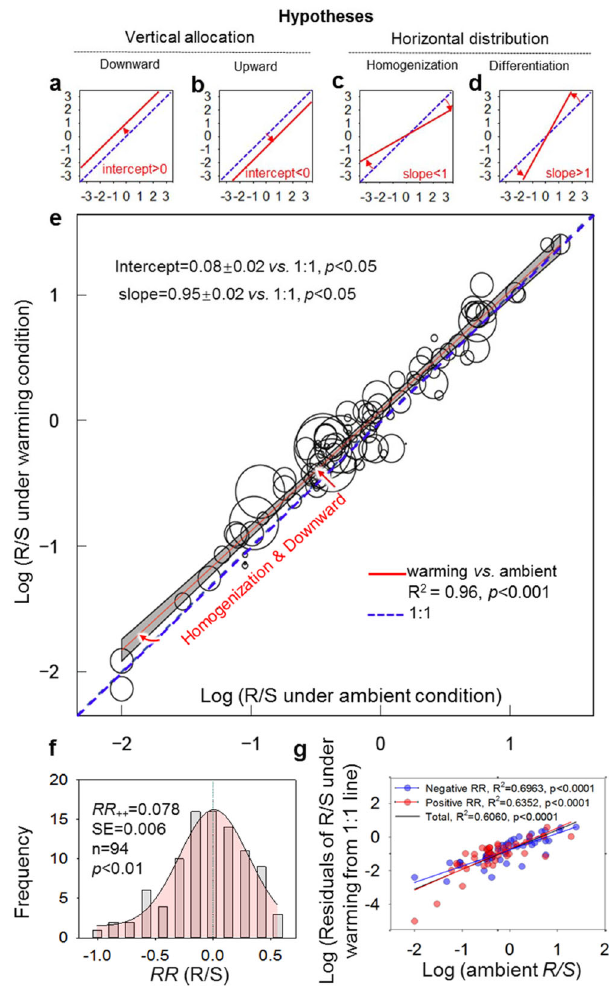
Fig. 1 | Hypotheses and actual warming effects on root:shoot ratio. a – d Hypotheses of the warming effect on root:shoot ratio (R/S). e The actual relationshipbetweenlog10-transformedR/Satexperimentalwarmingandambient temperature. f The frequency distribution of response ratio of R/S. g The log10- transformed residuals of R/S under the warmed condition from 1:1 line along with log10-transformed R/S under ambient condition. The error bands in panel e represent the upper and lower 95% con fi dence intervals. Across studies in our meta-analysis, the interceptin panel e was larger than 0, implying greater biomass is allocated (vertically) downwards, i.e., greater R/S under warming than that at ambient temperature ( a , e ); the opposite scenario of downward allocation (i.e., upward allocation, intercept smallerthanzero)isillustratedin panel( b ).Whenthe slope is smaller than 1, it would imply that warming decreases the horizontal variabilityofR/SandthuscausesthehomogenizationofR/Samongdiversebiomes ( c , e ); the opposite scenario of homogenization (differentiation, slope >1) is illu- strated in panel ( d ). The size of each dot in panel e indicates the relative weight of the individual response ratio of R/S. The p -value of the normal distribution test of RR (R/S) was0.3818.The RR ++ indicates the weighted response ratioof R/S inpanel ( f ); the ‘ n ’ in panel ( f ) is the sample size of the response ratio of